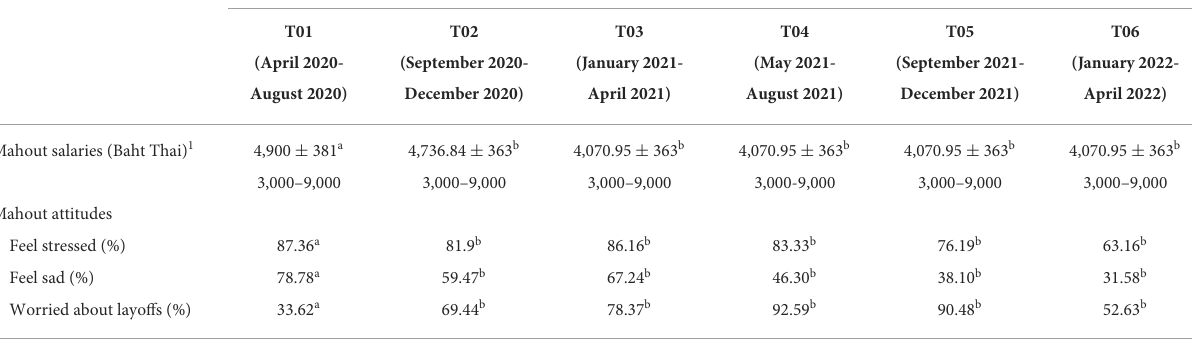
TABLE 2 Mean ( ± SEM) and percentage of answers on the mahout surveys ( n = 214) conducted over 2 years during the COVID-19 pandemic.